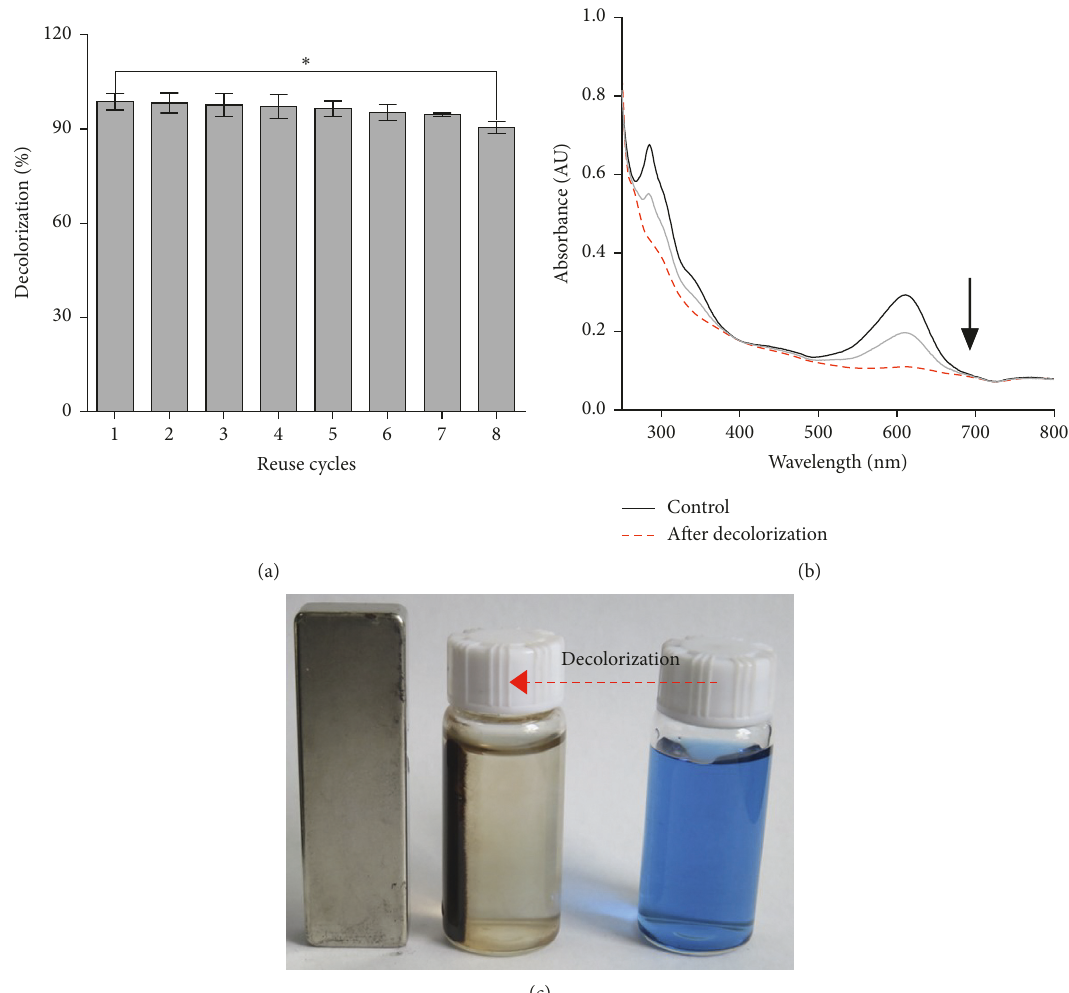
Figure 9: (a) Reusability of SA@MNPs over 8 successive cycles. (b) UV-Vis spectra of IC at various times during the enzymatic degradation process. (c) Photograph of the dye solutions before and after decolorization and the magnetic recovery of